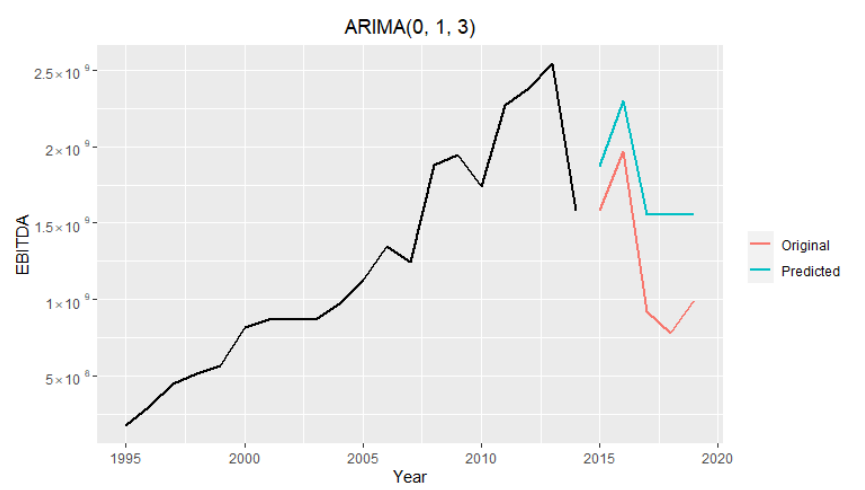
Figure 8. DES forecast using λ = 0.8 and Equation (18).